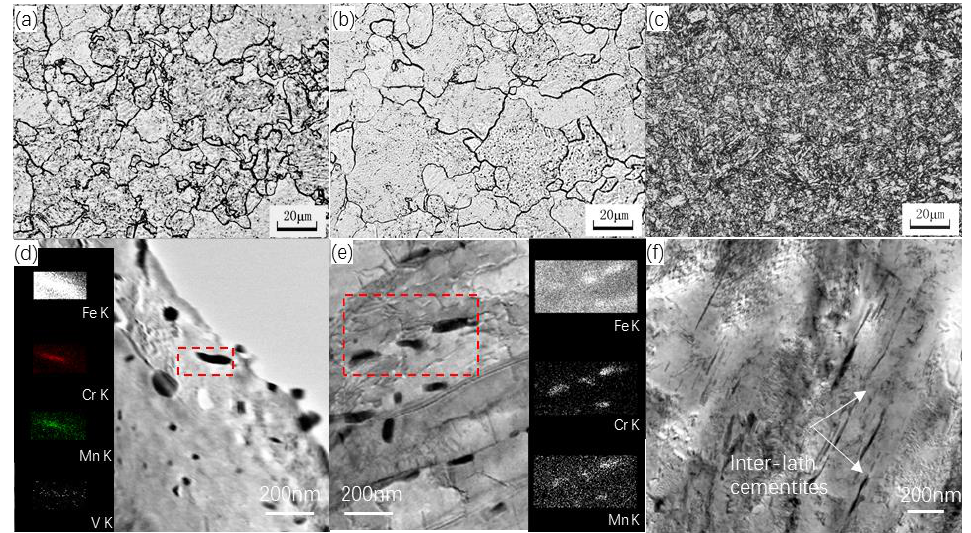
Figure 3 . Microstructure of the as-received CNST1, CNST2 and CNSS3, ( a – c ) metallographs; ( d – f ) bright field TEM images; ( a , d ) CNST1; ( b , e ) CNST2; ( c , f ) CNSS3. ( d – f ) bright field TEM images; ( a , d ) CNST1; ( b , e ) CNST2; ( c , f )